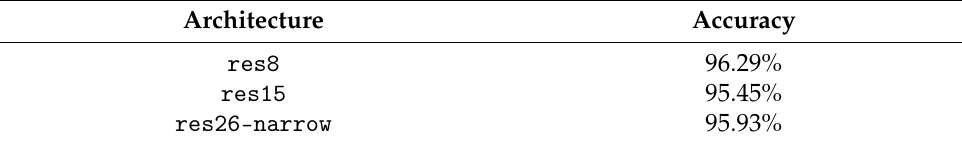
Table 4. Test accuracy for models pre-trained on the Google Speech Commands data set [38].